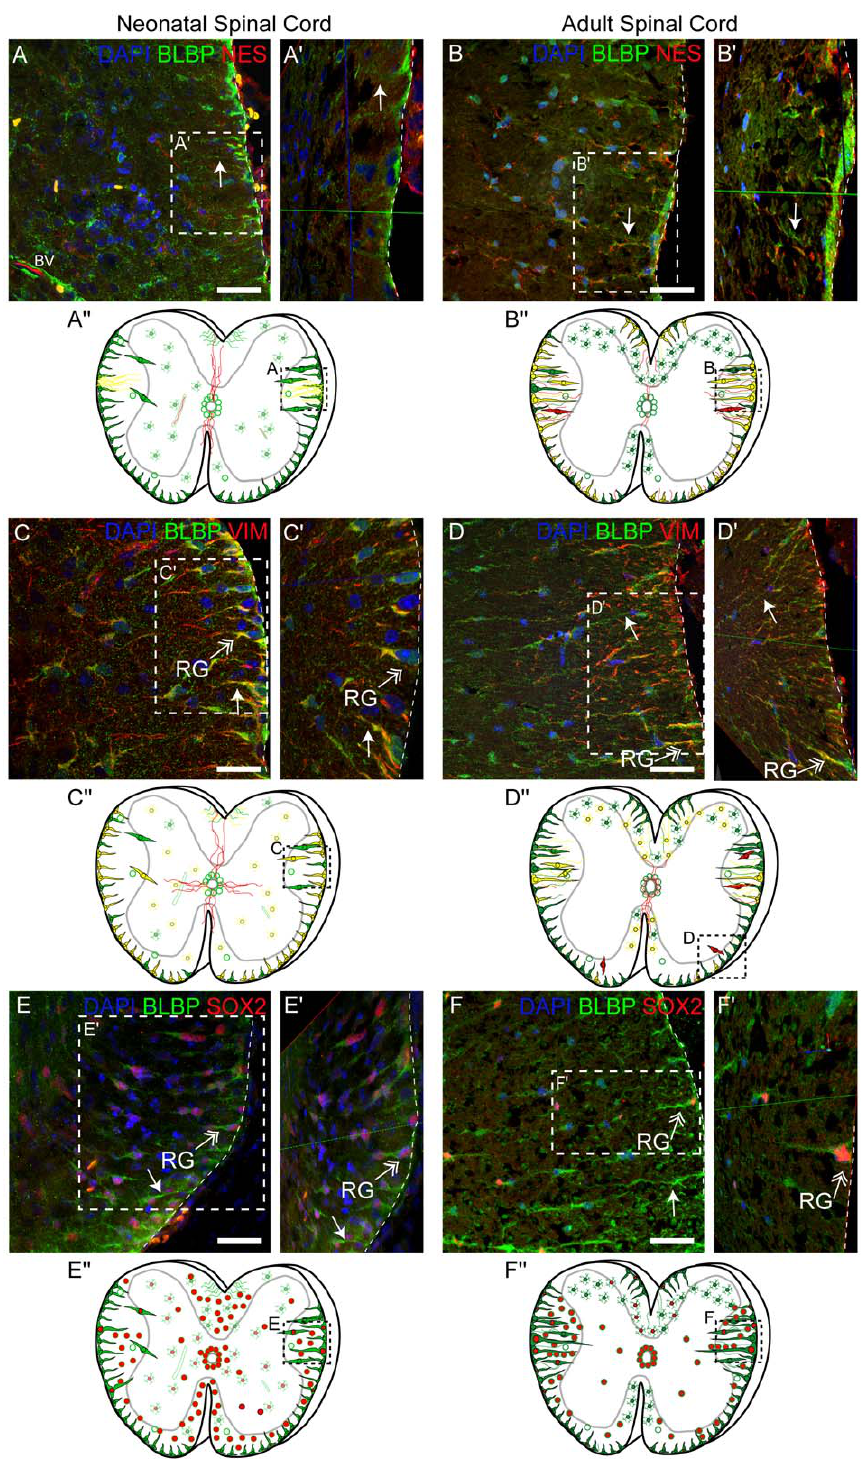
Figure 3. Spinal Cord Radial Glia Heterogeneity is Highlighted by the Co- Expression of Neural Stem Cell Proteins in the Neonatal and Adult Spinal Cord. (A, C, E) In the neonatal (PND 5) SC, confocal imaging shows that BLBP + (green) SCRG extend processes (arrows) from the marginal edge of the SC and through the WM. These cells (A) rarely co-express NES (red), but distinct subpopulations (B) robustly co-express VIM (red) and (E) nuclear SOX2 (red). Boxed areas outline higher magnifications (A 9 –F 9 ) of the z-stacks, rotated on a 3D plane to highlight the anchored SCRG cytoarchitecure at the pial boundary. (B, D, E) In the adult (PND 75) SC, the BLBP + (green) SCRG are less abundant, but their processes display enhanced expression of (B) NES (red) and (D) VIM (red). (F) SCRG nuclei remain at the sub-pial edge of the SC, where rare subpopulations retain expression of SOX2 (red). (A 0 –F 0 ) Distribution of progenitor marker expression is depicted in schematics of SC cross-sections, and highlight the shifting cytoarchitecture of the SCRG and CC progenitors of the neonatal and adult SC. Immuno-positive multipolar cells and BV are included. Arrow: SCRG process; double arrow: SCRG; dotted line: marginal edge of SC; BV: blood vessels. Scale bars: 50 m m. doi:10.1371/journal.pone.0024538.g003 PLoS ONE |